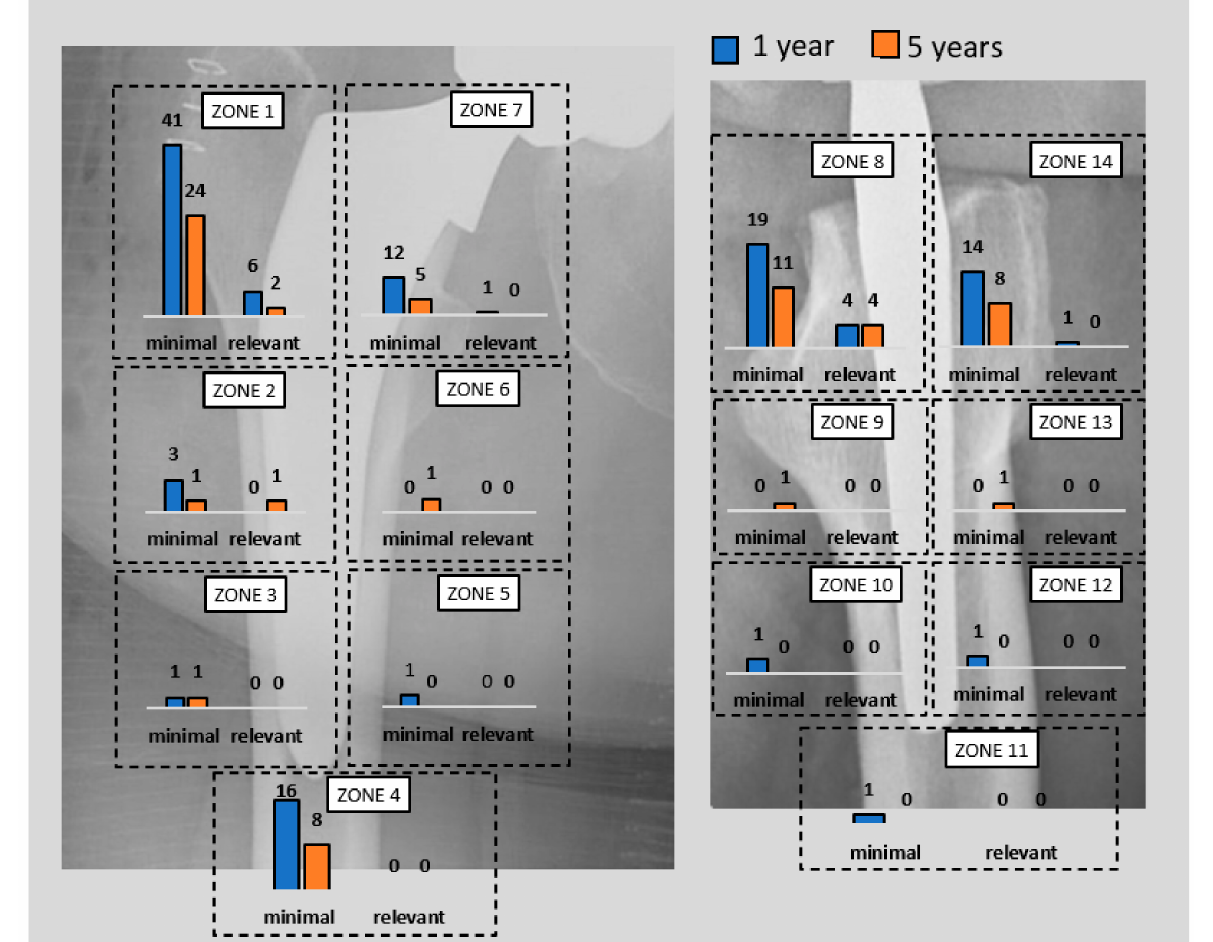
Figure 3. Minimal and relevant radiolucencies at 12 months and five-year follow-up according to the Gruen zones classification